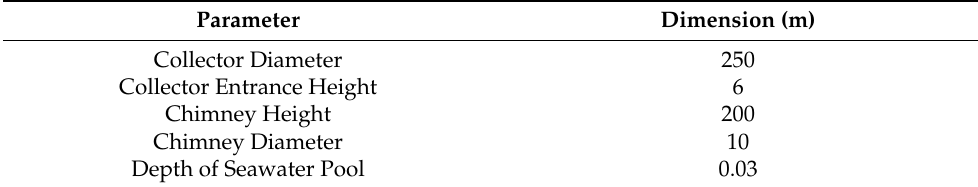
Table 1. Dimensions of the PV-SCPP